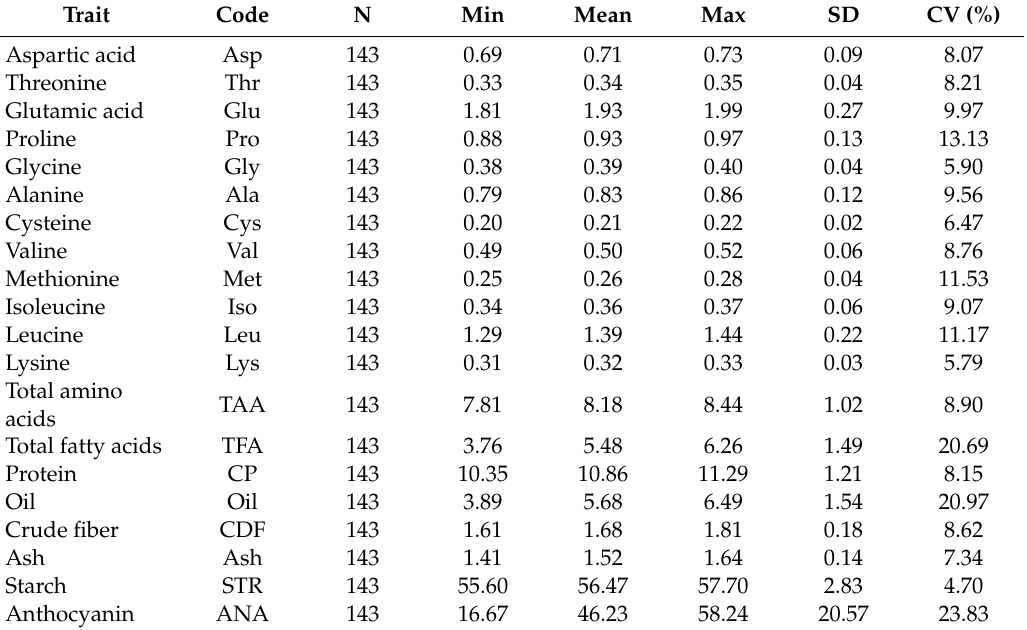
Table 1. Descriptive statistics of wet lab analyzed grain compositional traits. Amino acids (Asp, Thr, Glu, Pro, Gly, Ala, Cys, Val, Met, Iso, Leu, Lys), TAA, TFA, CP, Oil, CDF, Ash, and STR were measured in % while anthocyanin was measured in mg / 100 g.